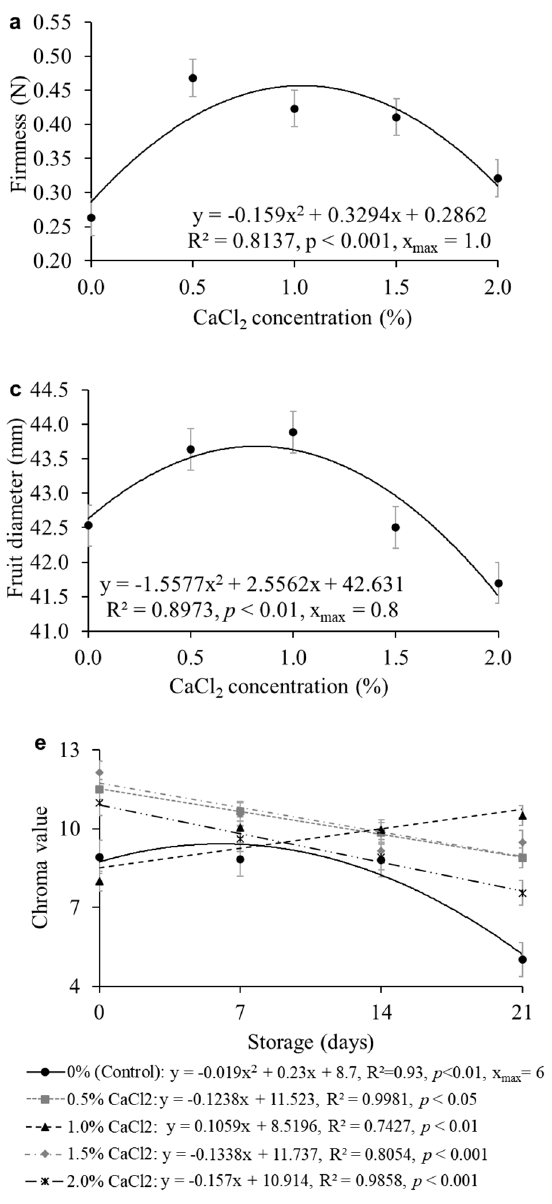
Figure 5. Firmness ( a , b ), diameter ( c , d ), chroma value ( e ) and hue angle ( f ) of ‘Roxo de Valinhos’ fig fruits as a function of CaCl 2 concentrations and storage days at 5 ± 1 °C and 90–95% R.H. Bars symbolise standard errors (n = 4).